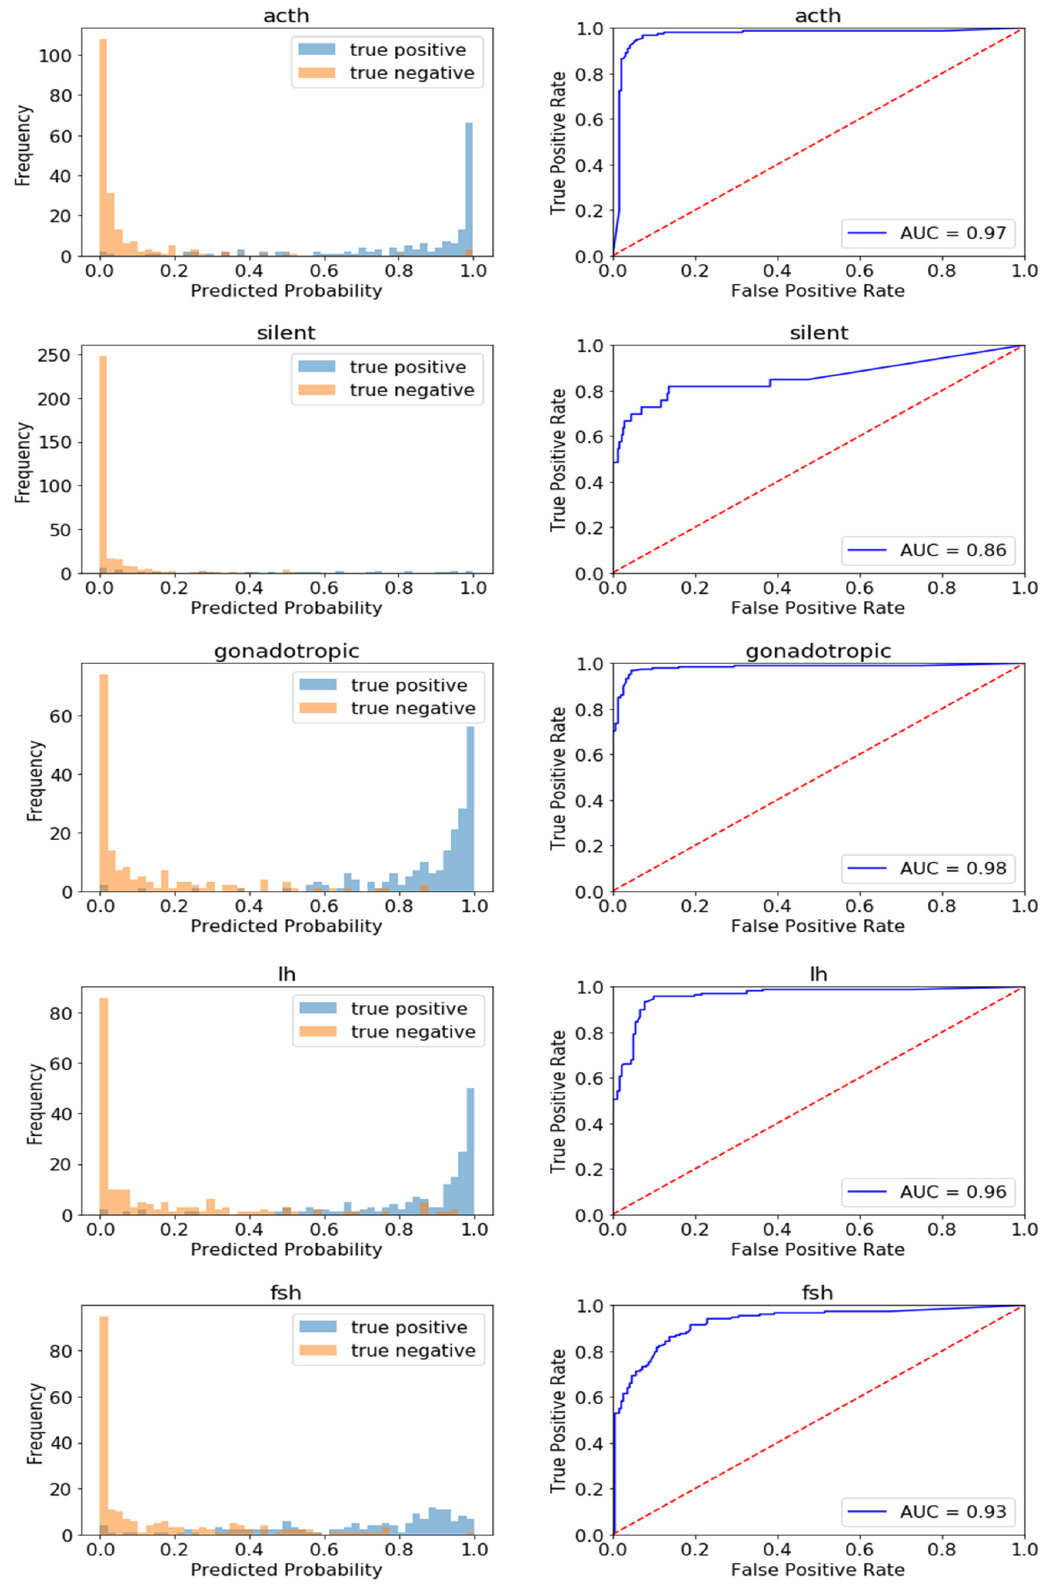
Figure 4. Results | Histograms and ROC-Curves were calculated on a case basis. The predictions were made for all 5 validation sets with the corresponding model that was not trained on that validation set. So, the graphs represent the complete dataset.